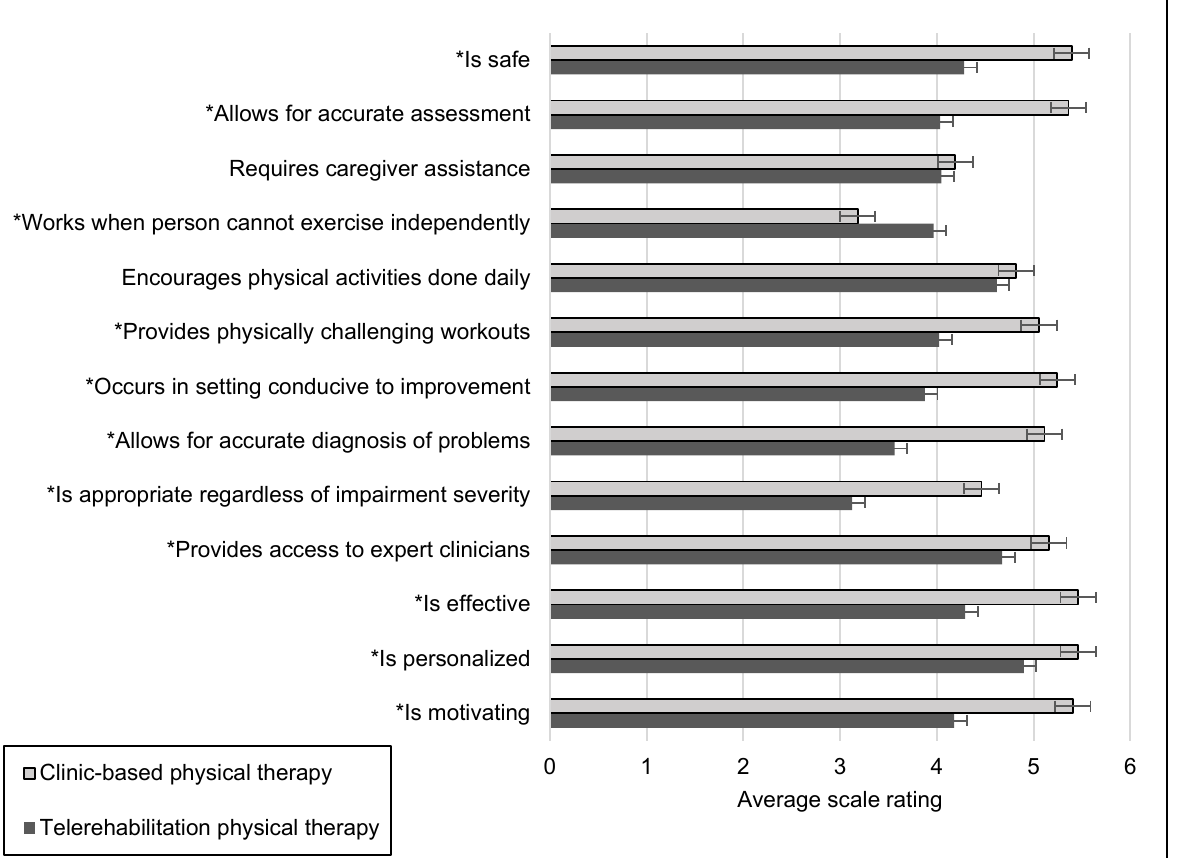
Average Likert-type Scale Ratings Concerning Service Delivery Quality and